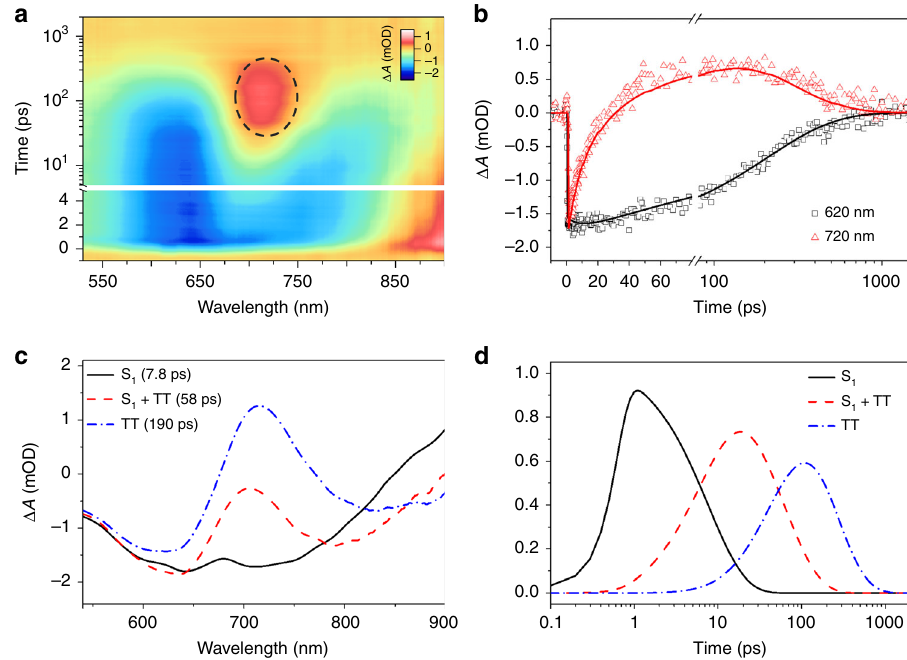
Fig. 2 Transient absorption data. a Transient absorption of IIDDT-Me in the diluted DCB solution is shown in a pseudo-color plot, the dotted circle highlights the triplet transient signal. b The dynamics taken from GSB at 620 nm and ESA at 720 nm are shown with kinetic traces (open circles) and fi ts (solid lines). c A sequential global analysis model shows three species that we assign to the photoexcited singlet (S 1 ), triplet pair (TT), and singlet and triplet coexistence state (S 1 + TT). d The normalized population concentration versus